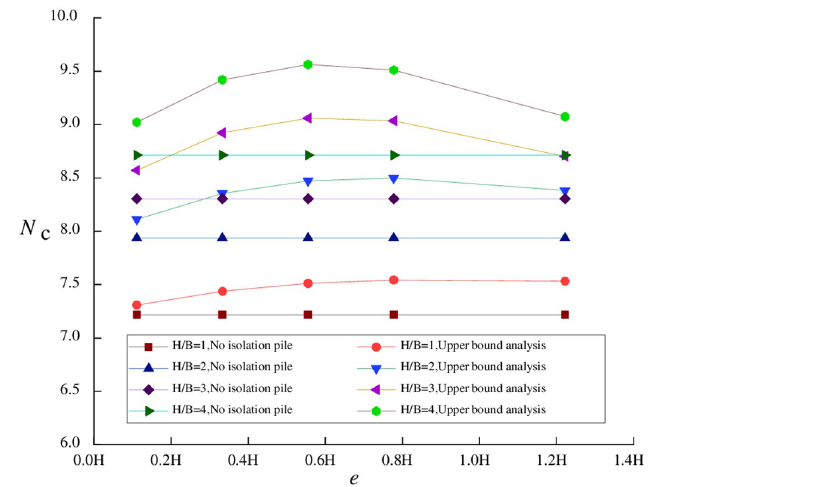
Fig 6. Relationship between the stability coefficient and e ( t =